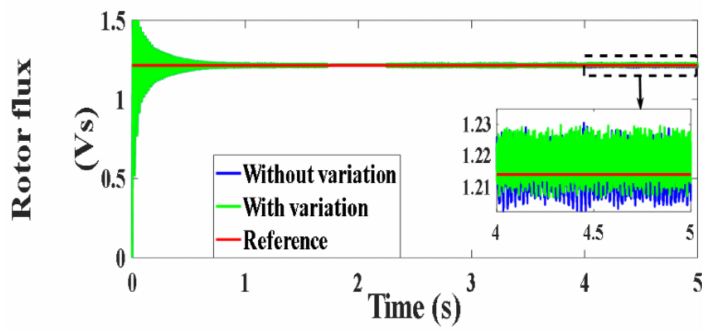
Figure 142. Rotor flux under PVC